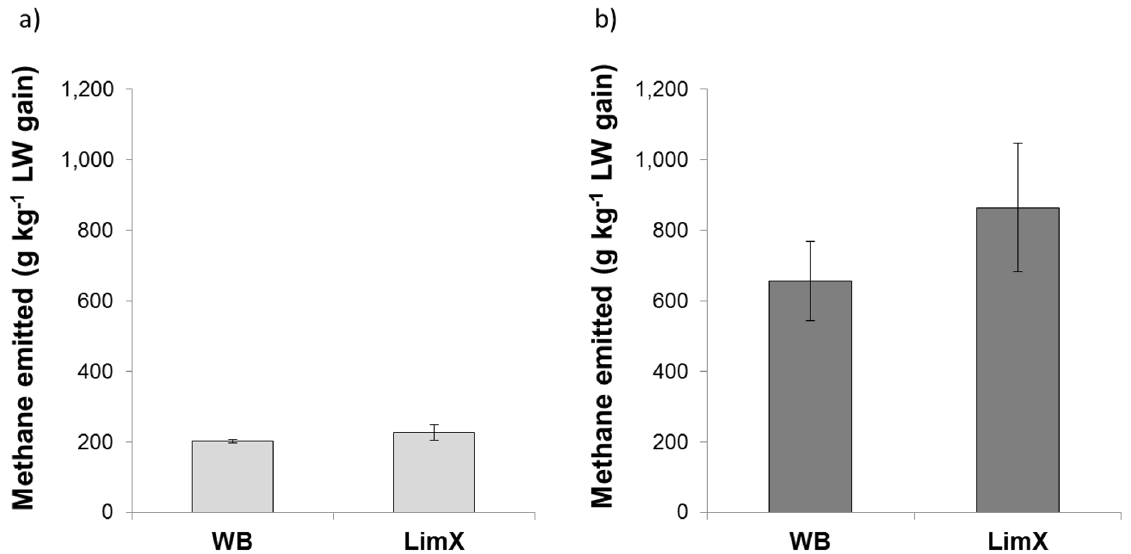
Figure 2. Effect of breed type on methane emissions per kilogram of live-weight (LW) gain for steers grazing on a) lowland ryegrass, and b) semi-improved hill pasture. (Where WB=Welsh Black and LimX=Limousin cross; values plotted are mean 6 standard errors).